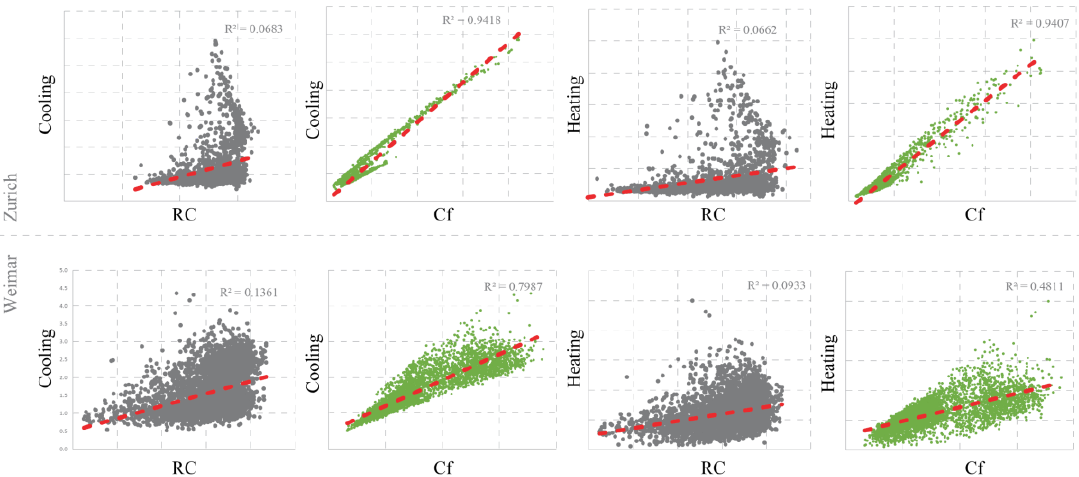
Figure 12. Correlation of energy demand (winter and summer) to the relative compactness (RC) and shape coefficient (C f ) for the two cases of Zurich (top row) and Weimar (bottom row).